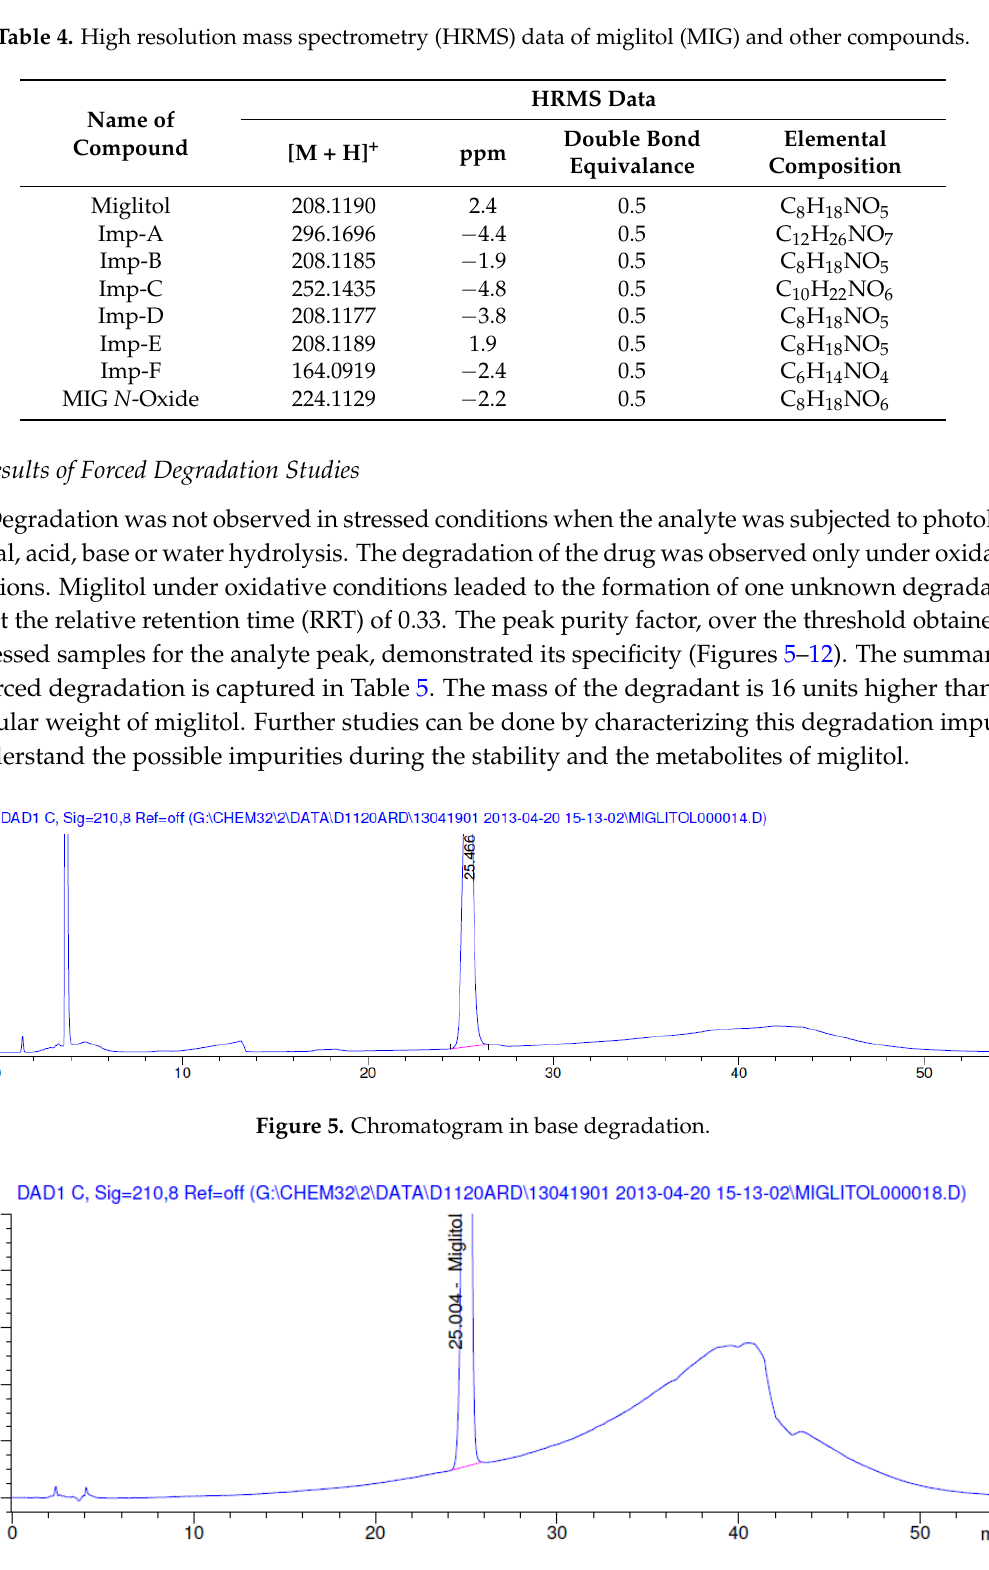
Figure 6. Chromatogram in thermal degradation.